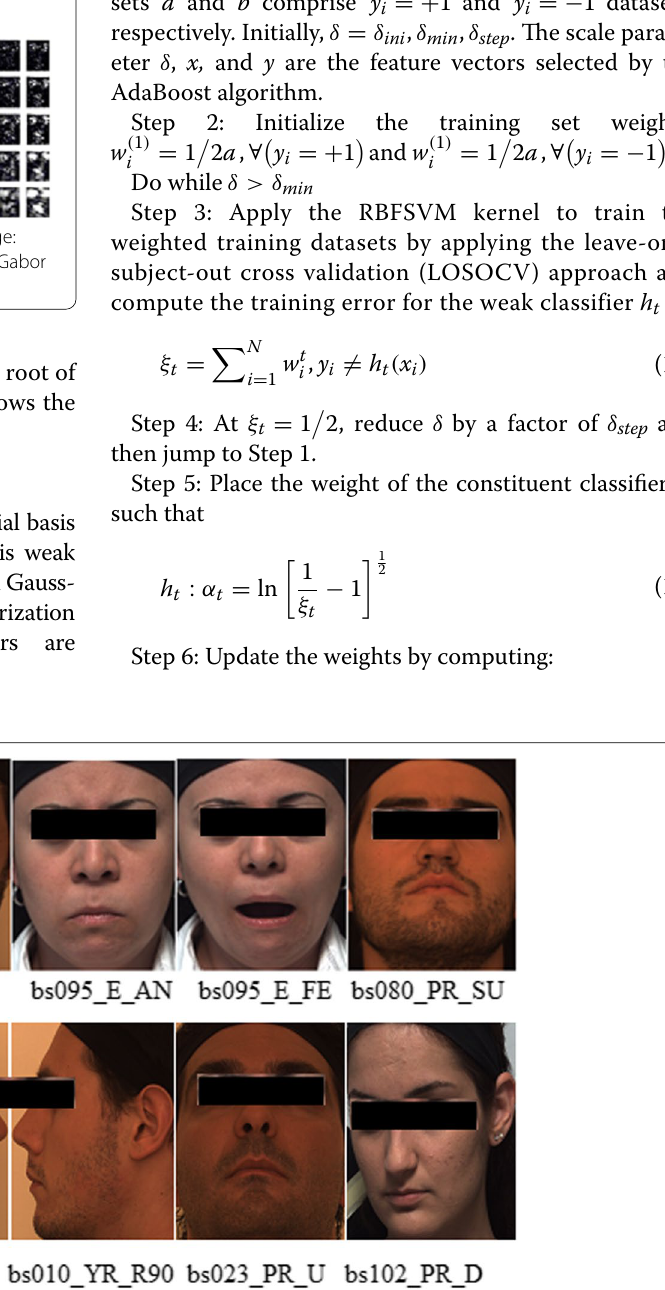
Fig. 6 Sample Bosphorus